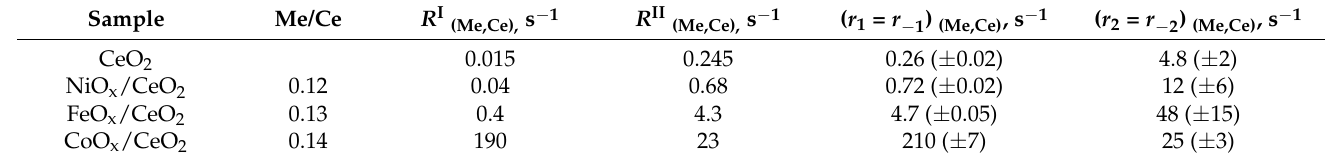
Table 5. Me/Ce (Me = Ni, Fe, Co) atomic ratios in the surface layers (XPS) of different MeO x /CeO 2 samples, normalized rates of isotope exchange on MeOx and CeO 2 ( R I (Me,Ce) and R II (Me,Ce) ) and rates of reactions of stages 1 and 2 (Scheme 1) of isotope exchange on different sites (( r 1 = r − 1 ) (Me,Ce) and ( r 2 = r − 2 ) (Me,Ce) ). Me concentration—0.86–0.91 wt.%.